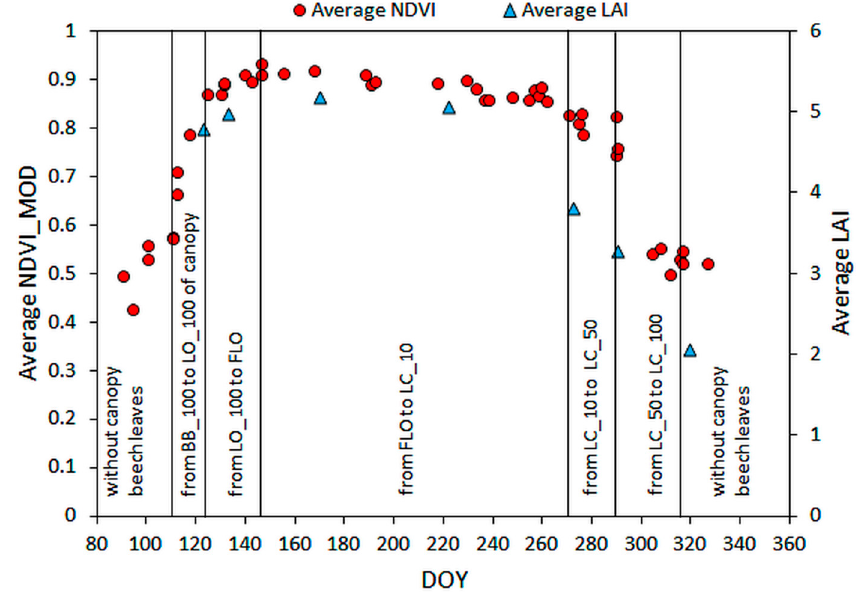
Figure 5. Seasonal changes in the NDVI MOD and LAI averaged over the test stands of U1–U5 in 2011. The year was divided into sections according to the phenological phases of canopy beech trees. NDVI_MOD, normalized difference vegetation index from MODIS data, LAI, leaf area index. DOY, day of year. BB_100, end of bud bursting. LO_100, end of leaf onset. LC_10, beginning of leaf coloring. LC_50, general leaf coloring. LC_100, end of leaf coloring.